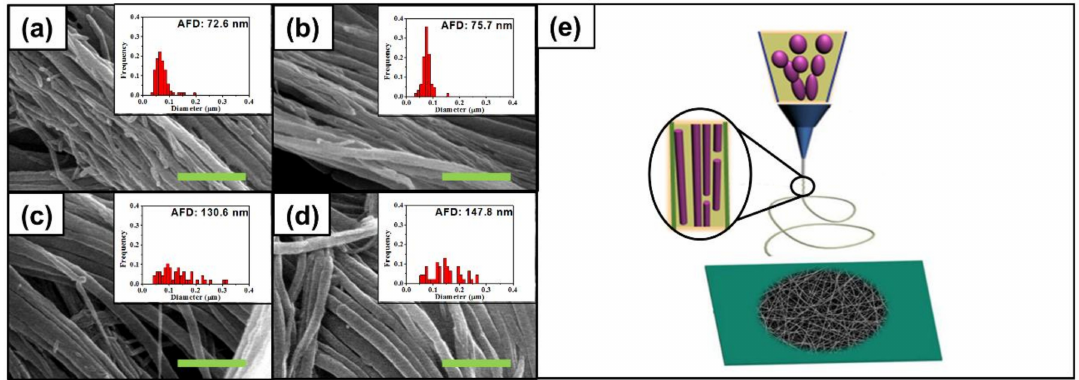
Figure 3. SEM images and diameter distributions of electrospun PEI/PVdF (1:1 wt. ratio) fibers collected after the interval of ( a ) 10 min; ( b ) 20 min; ( c ) 30 min; and ( d ) 40 min and ( e ) schematic showing the formation of membranes containing multicore-shell structured fibers during electrospinning. The green scale bars are 1 µ m. The frequencies in insets were normalized by the number of counted samples. AFD is the abbreviation for average fiber